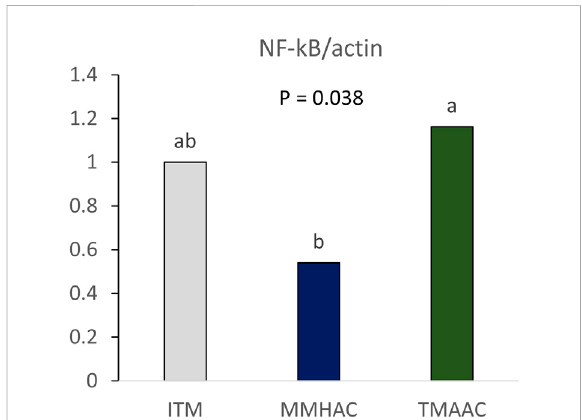
FIGURE 1 Effect of inorganic or organic trace minerals on jejunal NF κ B gene expression in broiler breeders at 24 weeks of age. ab Means without a common superscript differ ( p ≤ 0.05). ITM — inorganic trace minerals: 100, 16, and 100 ppm of Zn, Cu, and Mn respectively, as sulfates; MMHAC-mineral methionine hydroxy analog chelate: 50, 8, 50 ppm of bis-chelated MINTREX – Zn, Cu, and Mn (Novus International, Inc.), and TMAAC — trace minerals